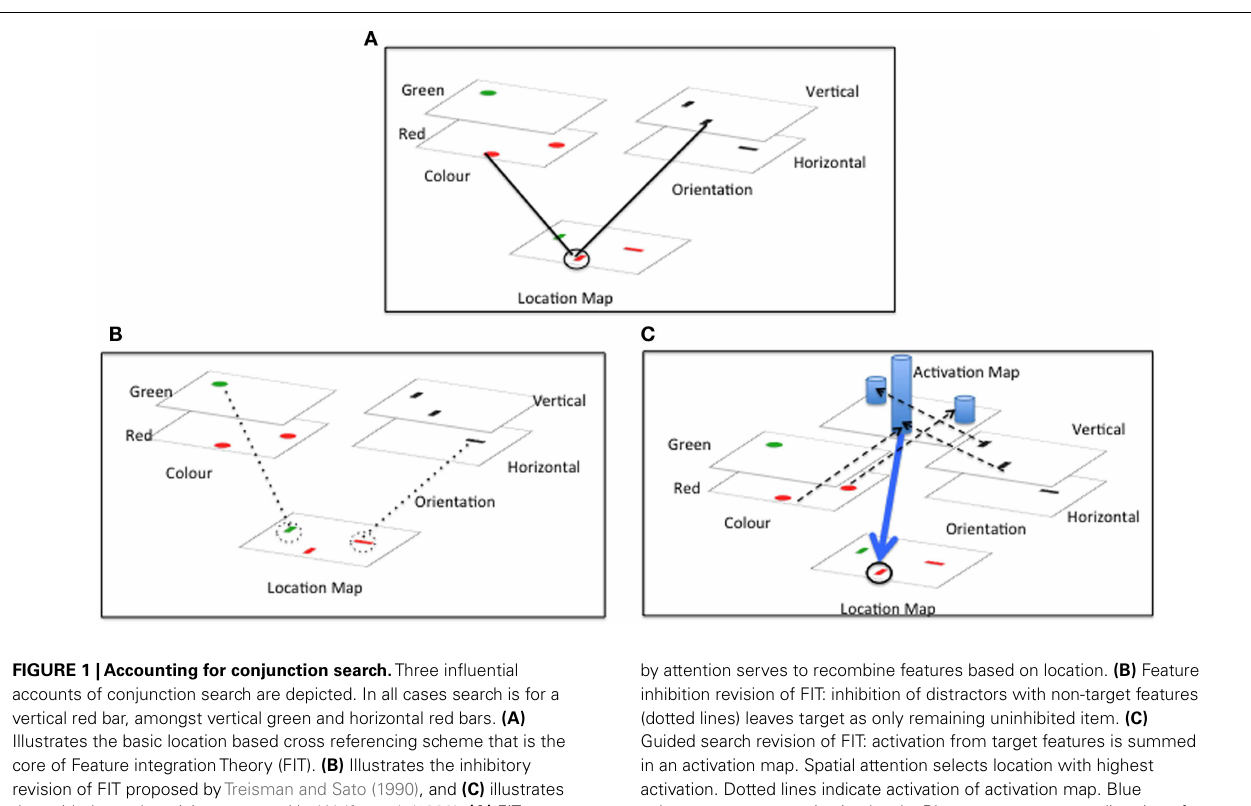
FIGURE 1 |Accounting for conjunction search. Three influential accounts of conjunction search are depicted. In all cases search is for a vertical red bar, amongst vertical green and horizontal red bars. (A) Illustrates the basic location based cross referencing scheme that is the core of Feature integrationTheory (FIT). (B) Illustrates the inhibitory revision of FIT proposed byTreisman and Sato (1990), and (C) illustrates the guided search revision proposed byWolfe et al. (1989). (A) FIT: stimuli are decomposed into constituent features. Serial spatial selection